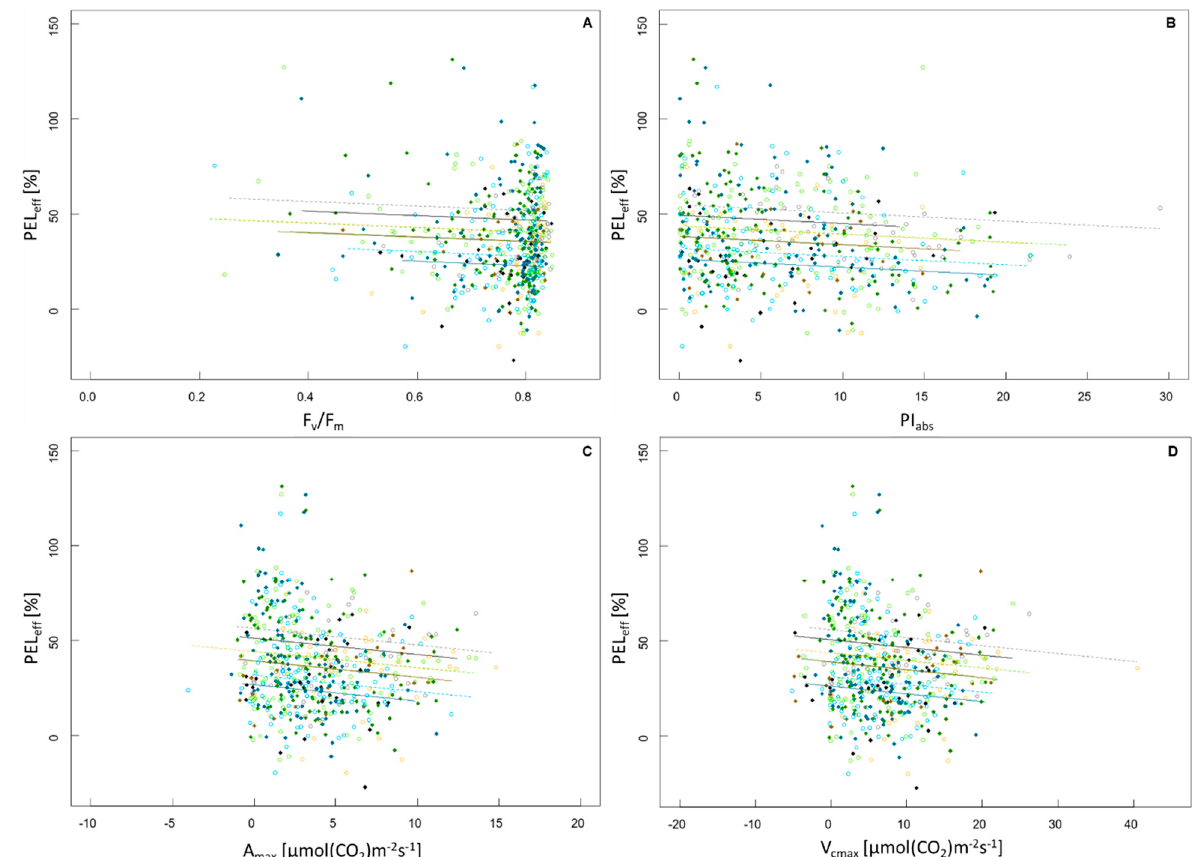
Figure 2. Trade-off between FR and photosynthetic performance represented by the relationship between the frost resistance as effective percentage of electrolyte leakage (PEL eff ) and ( A ) efficiency of PSII (F v /F m ), ( B ) performance index (PI abs ), ( C ) net CO 2 assimilation rate (A max ), ( D ) maximum carboxylation capacity (V cmax ). Species are represented by color, the evergreen species Q. ilex is displayed in light blue (inside) and dark blue (outside). Q. rhysophylla was colored in light green (inside) and dark green (outside). The deciduous species Q. palustris is shown in light gray (inside) and dark gray (outside) and Q. rubra is displayed in yellow (inside) and brown (outside). Individuals and species situated in the greenhouse are represented by open circles and a dashed line, individuals and species that experienced outside conditions are represented by a diamond and a continuous line. The regression line was based on the minimum adequate